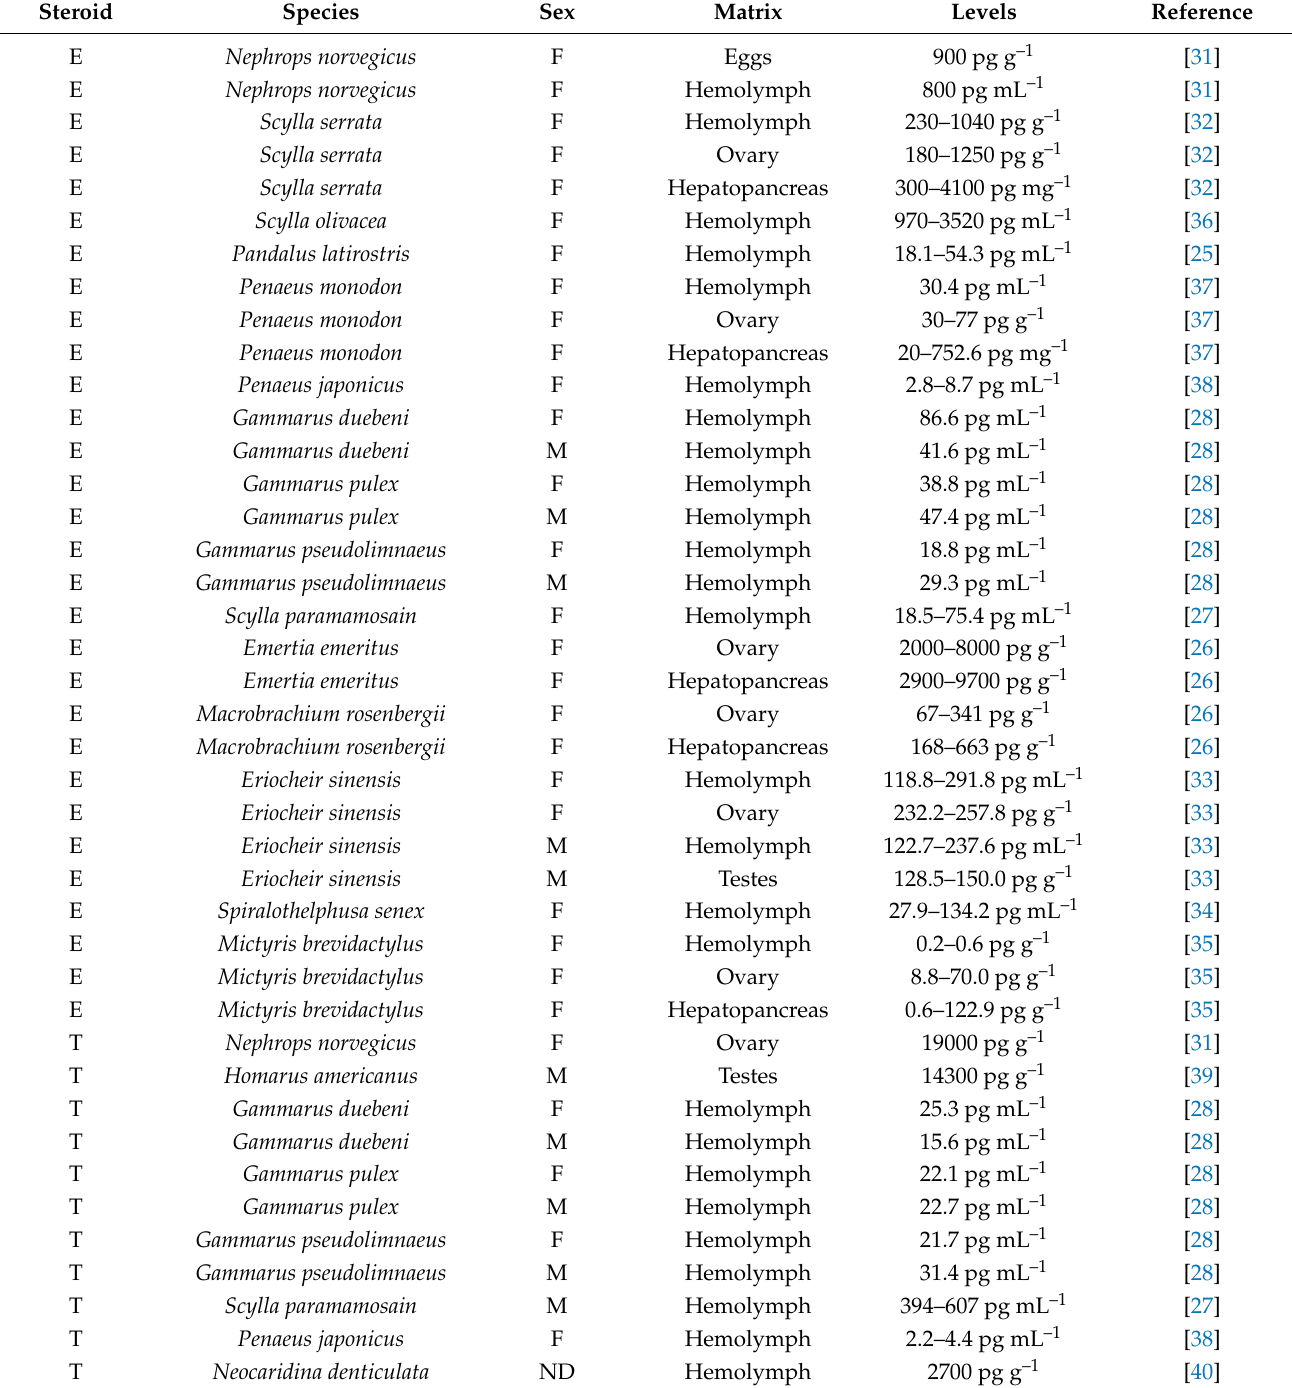
Table 2. Concentrations of vertebrate-like sex steroids identified in various crustacean species.